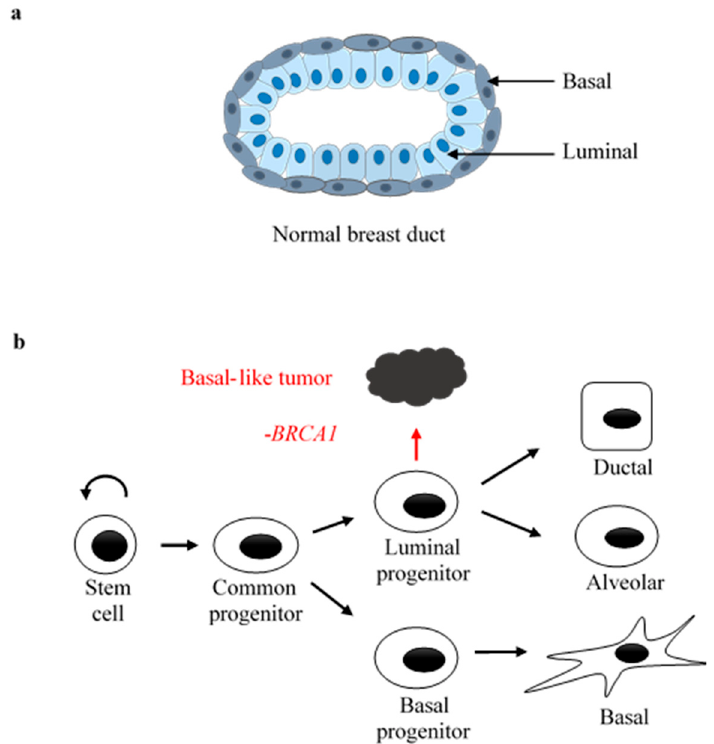
Figure 1. The developmental hierarchy of human breast. ( a ) Cross-section of a normal breast duct. ( b ) Breast epithelial hierarchy and BRCA1 -associated breast cancer.